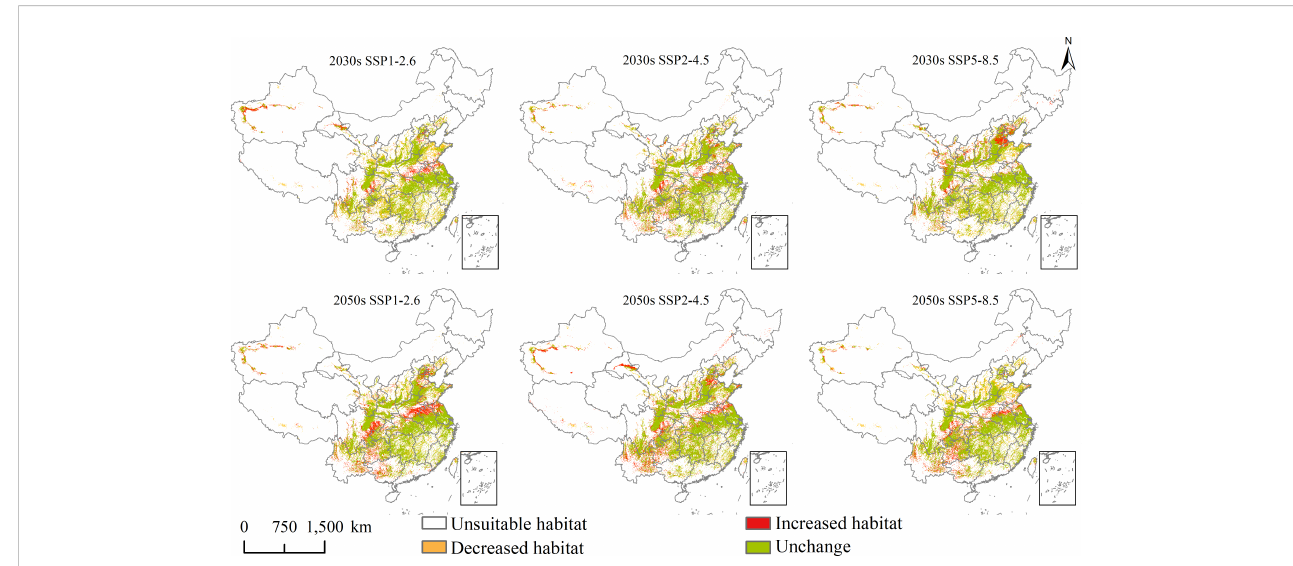
FIGURE 6 Future potential geographical distribution change of Lolium temulentum under three scenarios in the 2030s and